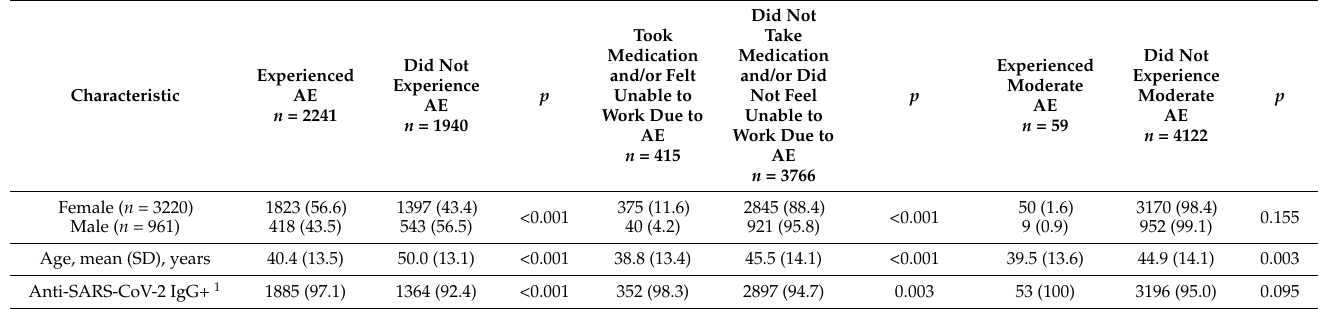
Table 3. Characteristics of participants who experienced and did not experience adverse events, took or did not take medication, and/or felt or did not feel unable to work, and experienced or did not experience moderate adverse events.